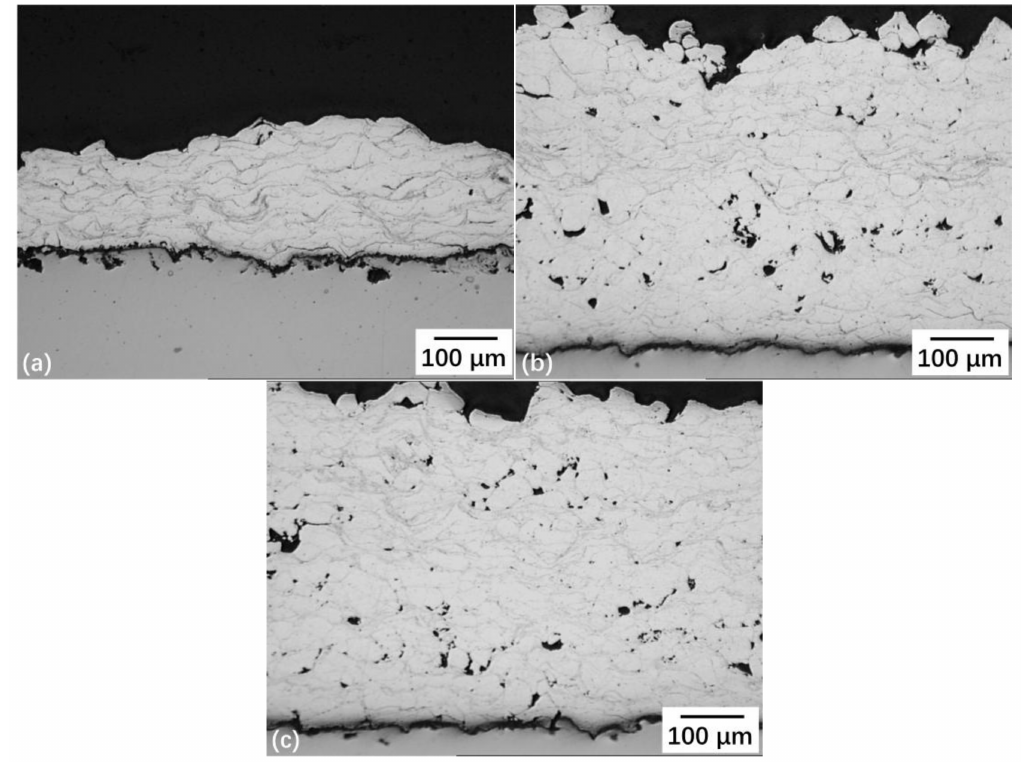
Figure 2. Microstructures of coatings deposited at 500 ◦ C ( a ), 550 ◦ C ( b ), and 600 ◦ C ( c ).